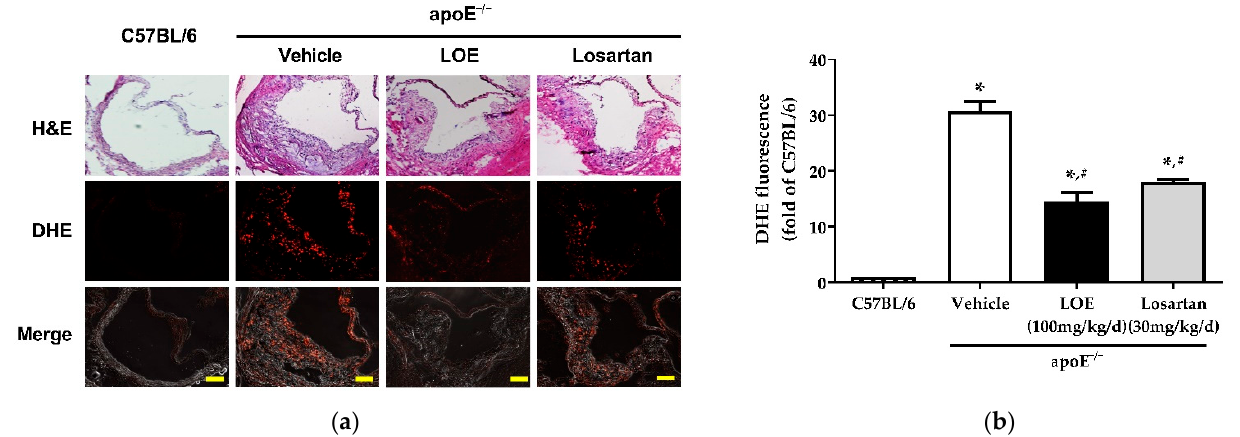
Figure 2. LOE and losartan treatments prevent vascular generation of reactive oxygen species in aortic sections derived from apoE − / − mice. The aortic sections were exposed to dihydroethidine (DHE, 2.5 µ M), a redox-sensitive fluorescent dye, for 30 min. Subsequently, ethidium fluorescence was evaluated via confocal microscopy. ( a ) Representative images show H&E staining ( top ), DHE staining in red ( middle ), and merged images ( bottom ). ( b ) Corresponding cumulative data. The scale bar represents 100 µ m. The results are shown as mean ± SEM ( n = 4–6). * p < 0.05 versus the C57BL/6 group and # p < 0.05 versus the apoE − / − vehicle